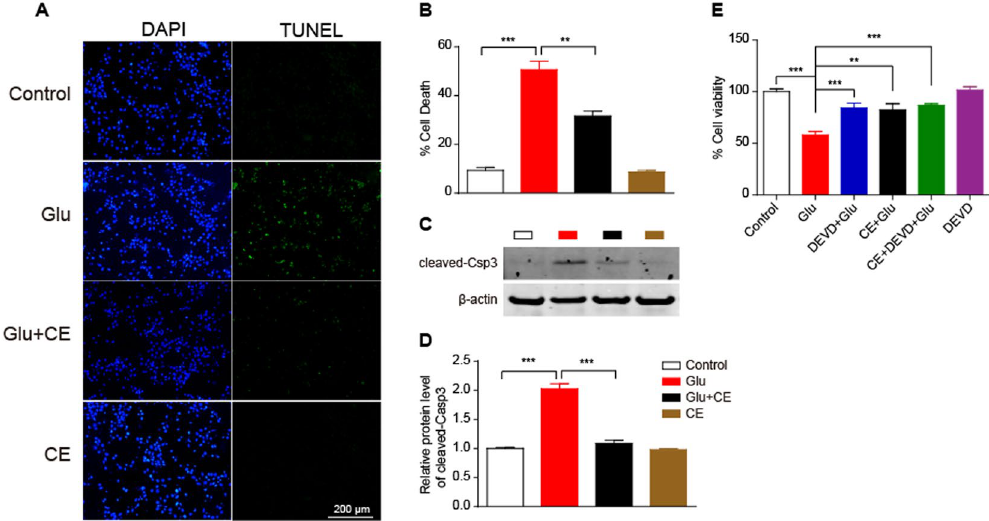
Figure 2. Glutamate-induced neuronal apoptosis is inhibited by CE. ( A ) Neuronal apoptosis was measured using the TUNEL assay. Drug treatments were the same as in Fig. 1, but a final CE concentration of 10 mg/ ml was used due to its better protective effect. The nuclei were stained with DAPI. ( B ) Quantification of the percentage of dead cells (TUNEL-positive cells/DAPI-positive cells). At least 100 cells from each group were counted. ( C and D ) Cell lysates were immunoblotted with an anti-cleaved-caspase3 antibody. The protein expression levels shown in ( D ) were quantified using ImageJ software. cleaved-csp3, cleaved-caspase3. ( E ) cell viability was measured using MTT assay. Cells were pretreated with the caspase-3 inhibitor DEVD for 30 min prior to treatment with CE or glutamate. ( B and D ) n = 3; E, n = 6, data are shown as mean ± SEM; One-way ANOVA followed by Tukey’s multiple comparisons test. ** p < 0.01, *** p < 0.001. Scale bar, 200 μ